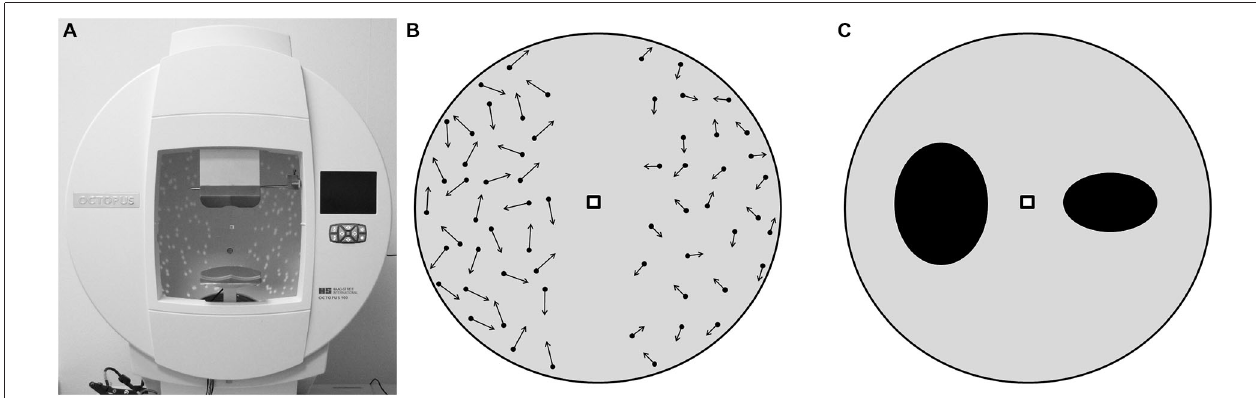
FIGURE 2 | Visual tests setup, as it appeared to the subjects. (A) hemispherical screen used to perform the tests. (B) Speed Task. The arrows represent the speed of the dots, which, in this example, are faster in the left hemisphere. Here subjects are asked to decrease the speed of the dots on the left in order to make them as fast as the dots on the right. (C) Shape Task with two ellipses, the axes ratio of the ellipse in the left hemisphere is higher than the one in the right. Here subjects are asked to decrease the axes ratio of the ellipse on the left in order to make it identical to the ellipse on the right.